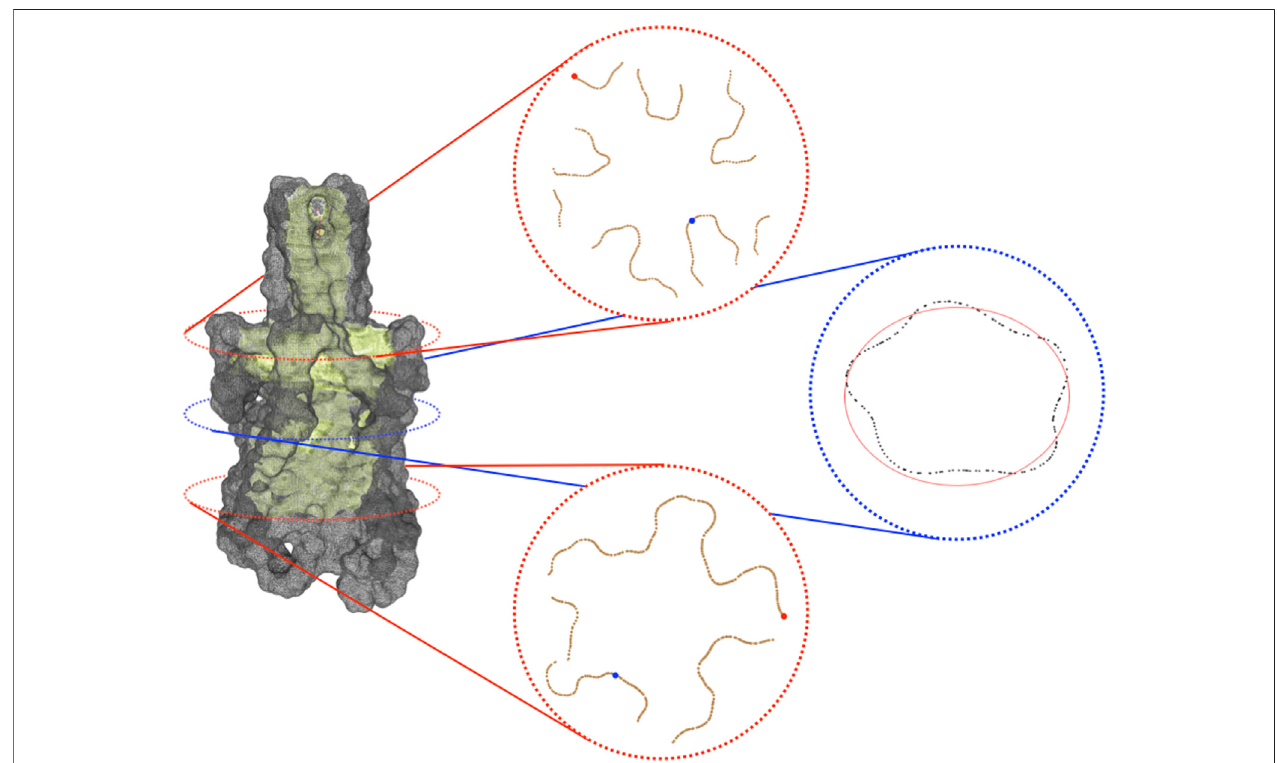
FIGURE 2 | Visible contour of a channel. On the left, is the visible contour of the channel (in light green) and the molecular surface (in grey). On the right, three sections of the visible contour: on the top, the section coinciding with the bifurcation of the skeleton; in the middle, the central section of the channel; at the bottom, a section clearly revealing the pentalobated nature of the channel. In each section, we spotlight some of the geometric features provided by the proposed approach. Speci fi cally, in the top and in the bottom sections, the closest and the farthest points to the centerline are represented in blue and red, respectively. In the middle section, the ellipse (depicted in red) that best fi ts it is shown. Its knowledge allows retrieving further information about the local channel shape, such as its